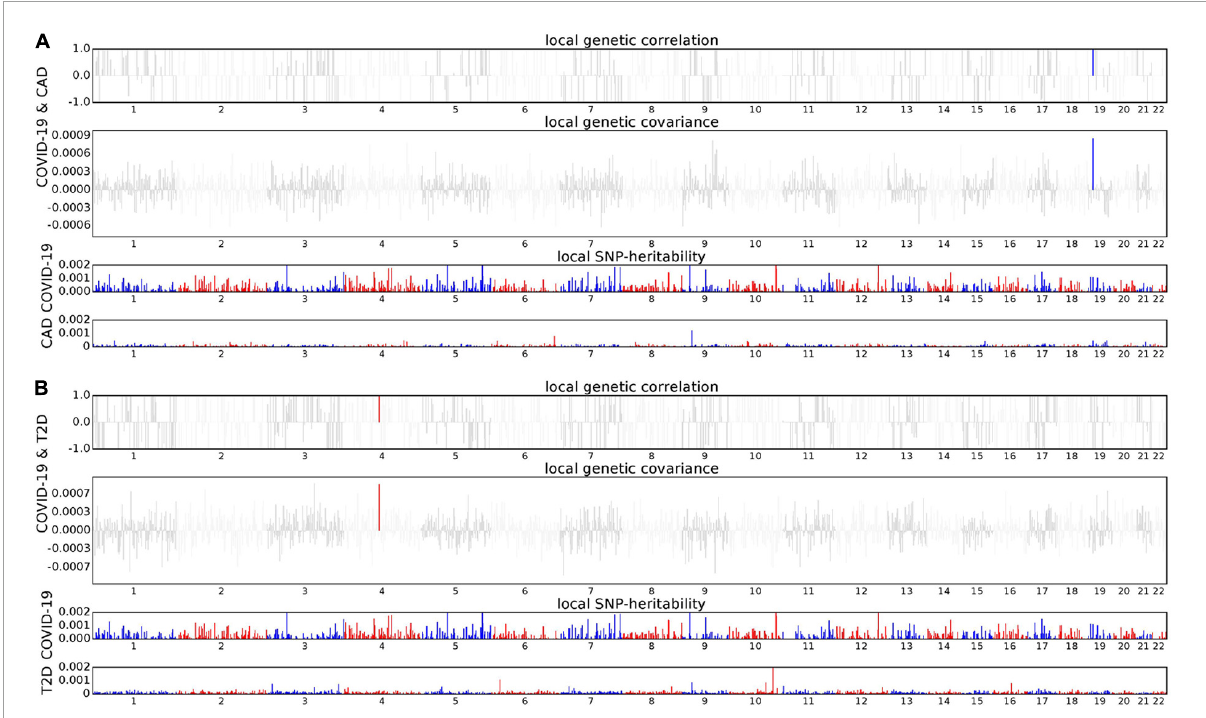
FIGURE2 Local genetic correlation and local SNP-heritability between COVID-19 and CAD (A) , T2D (B) , respectively. For each subfigure, the top part represents local genetic correlation, the middle part represents local genetic covariance, and blue or red highlights indicate significant local genetic correlation and covariance after multiple testing correction, the bottom part represents local SNP heritability for each trait.